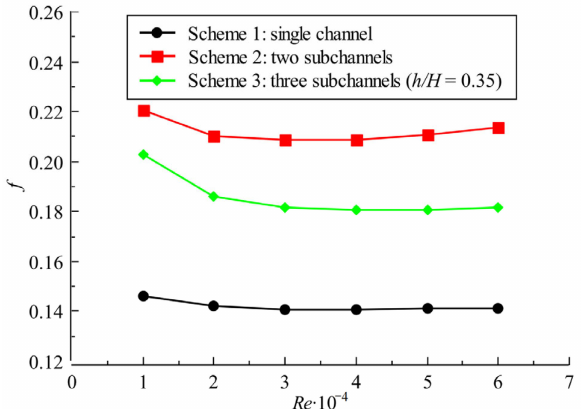
Figure 5. Comparison of flow performance of X-shaped truss array channels at different layout